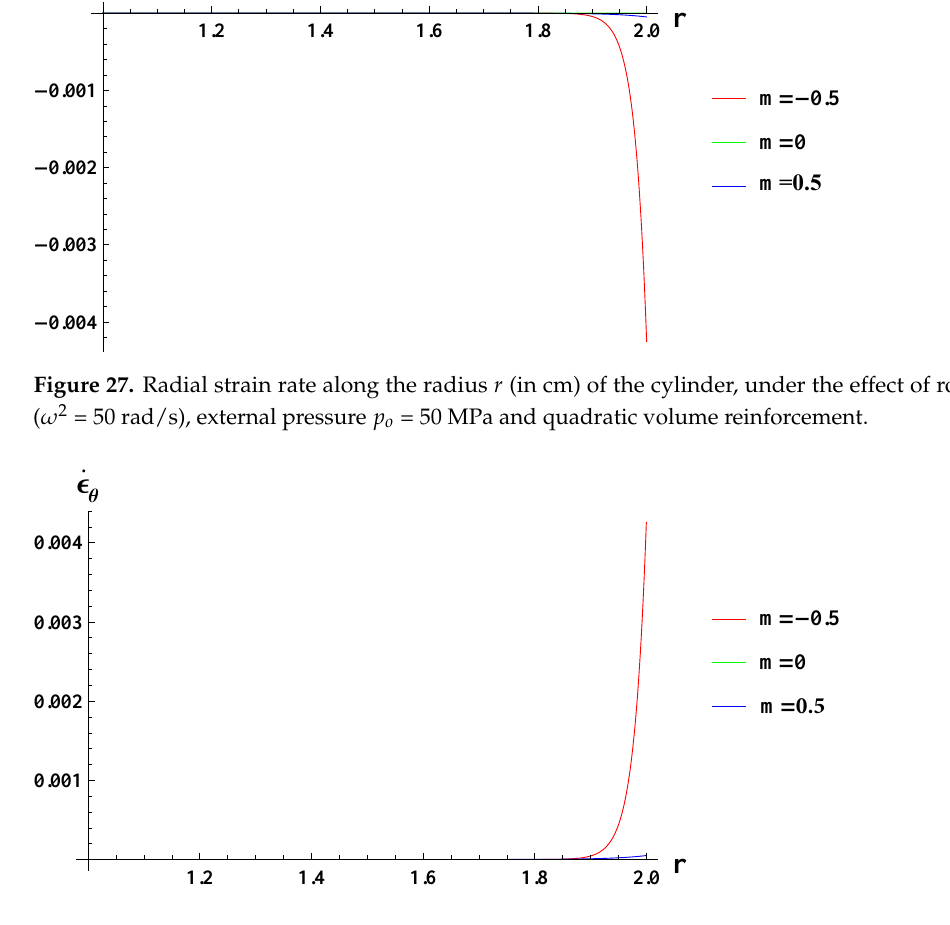
Figure 28. Tangential strain rate along the radius r (in cm) of the cylinder, under the effect of rotation ( ω 2 = 50 rad/s), external pressure p o = 50 MPa and quadratic volume